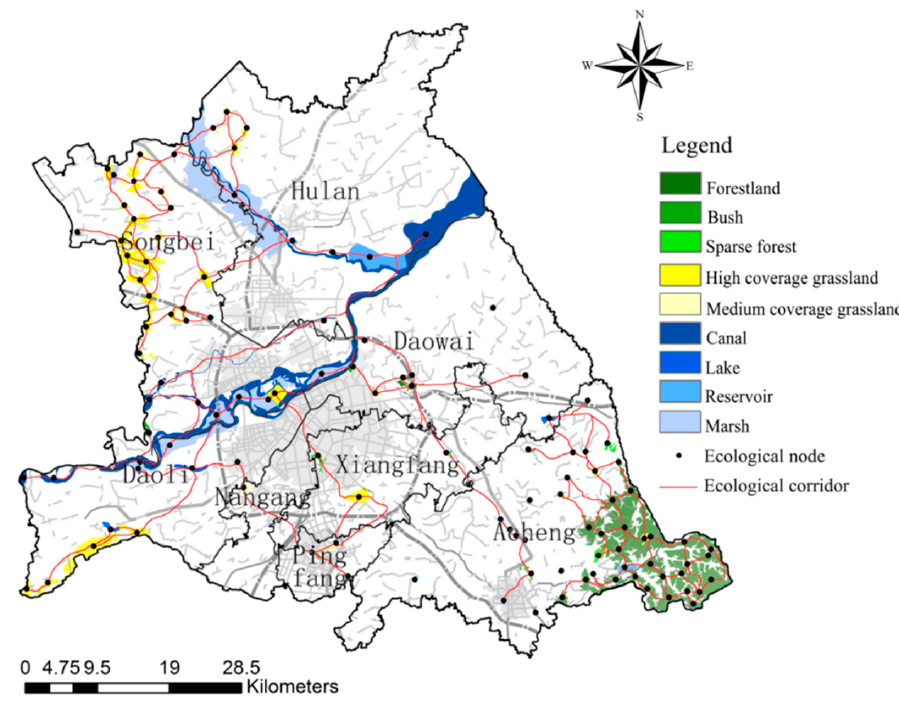
Figure 6. Ecological network in study the area.